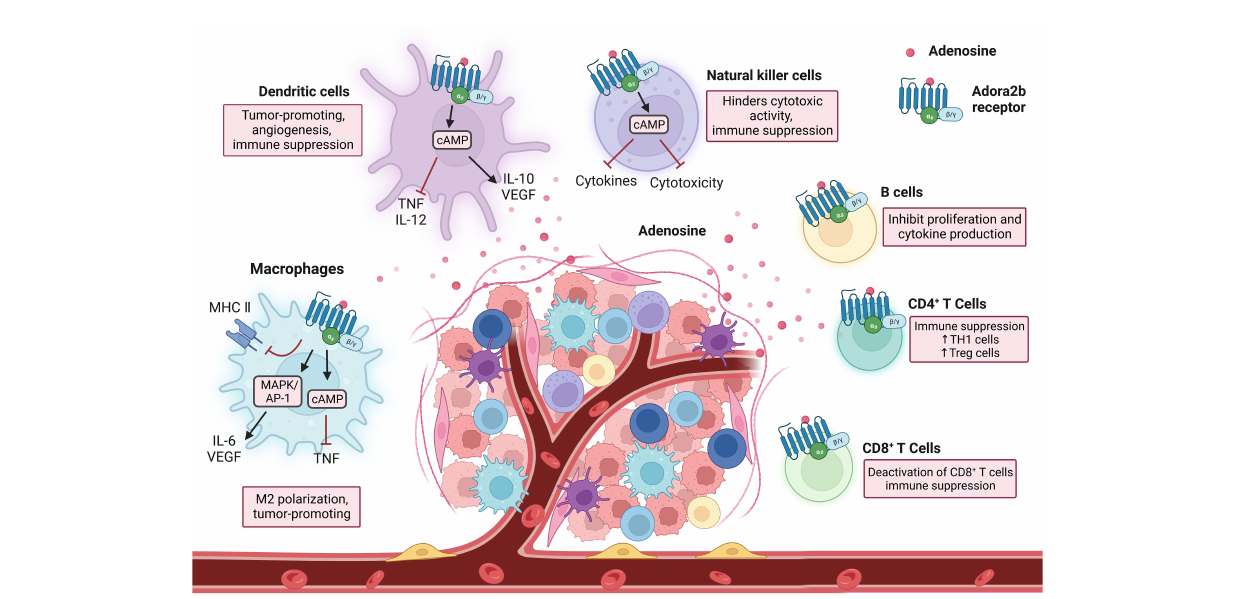
FIGURE 3 Immune cell interactions in response to Adora2b activation. As immune cells enter into the TME and encounter adenosine through the Adora2b receptor, they undergo changes resulting in immunosuppression. Adora2b activation on macrophages contributes to M2 polarization and tumorigenesis, as it inhibits MHC II expression, activates MAPK/AP-1 which increases IL-6 and vascular endothelial growth factor (VEGF) production, and increases cAMP levels which inhibits tumor necrosis factor (TNF) production. On dendritic cells, stimulation of Adora2b increases cAMP production which inhibits TNF and IL-12 production and increases IL-10 and VEGF release, resulting in tumorigenesis, angiogenesis, and immune suppression. Natural killer cells encounter adenosine through the Adora2b receptor and the cAMP pathway is activated resulting in blocked cytokine production and cytotoxicity, contributing to immunosuppression. On B cells, Adora2b activation results in the inhibition of proliferation and cytokine production. CD4 + T cell activation of Adora2b increases TH1 cell and Treg cell levels, as well as contributes to immune suppression. On CD8 + T cells, Adora2b activation results in the deactivation of CD8+ T cells and contributes to the suppression of the immune